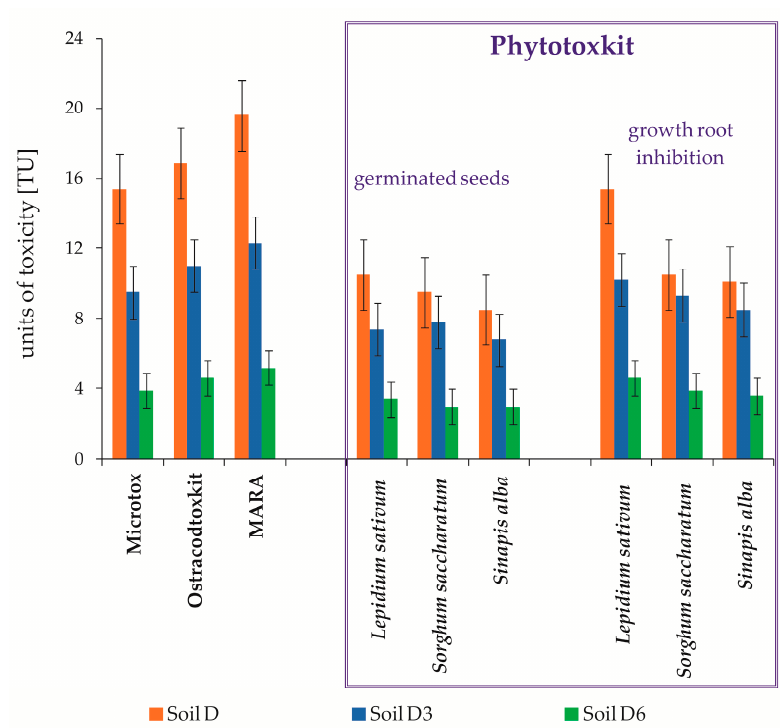
Figure 8. Comparison of toxicity test results expressed in toxicity units (TU) from non-sterile soil during inoculation with mixed culture M1 (ex-situ prism method) ( n = 3, p < 0.05): Soil D—raw soil; Soil D3—soil after 3 months; Soil D6—soil after 6 months.